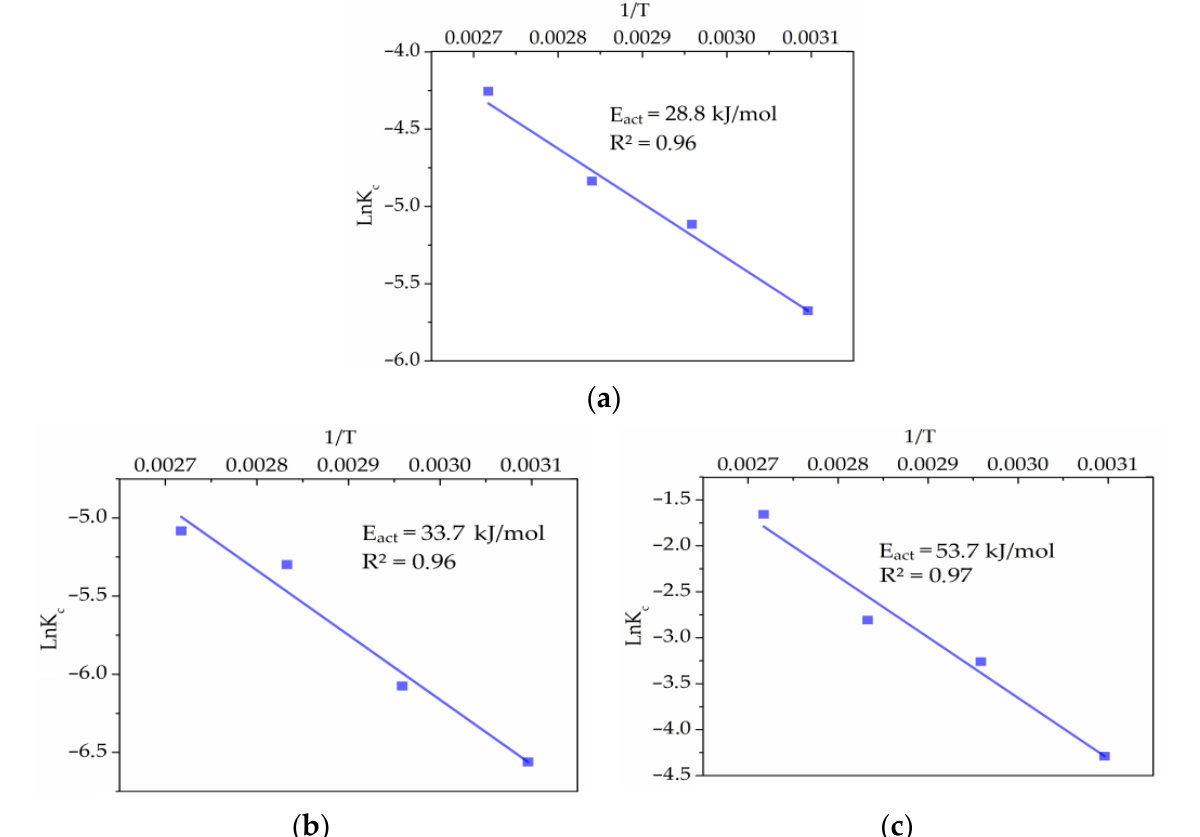
Figure 11. Arrhenius plots for Cu 12 As 4 S 13 ( a ), CuFeS 2 ( b ) and ZnS ( c ). The reaction order with respect to HNO 3 concentration, Fe (III) ions concentration and amount of FeS 2 additive were calculated using the graphical method (Table 4). The fractional order of reaction with respect to Fe (III) ions concentration and amount of FeS 2 additive at Cu 12 As 4 S 13 , CuFeS 2 and ZnS treatment suggests that the nature of the processes is diffusion controlled. At the same time, the reaction order with respect to HNO 3 concentration at Cu 12 As 4 S 13 , CuFeS 2 and ZnS treatment is more typical for chemical reaction control. The latter could be a result of aggressive impact on the S ◦ layer that allows it to overcome the effect of passivation.